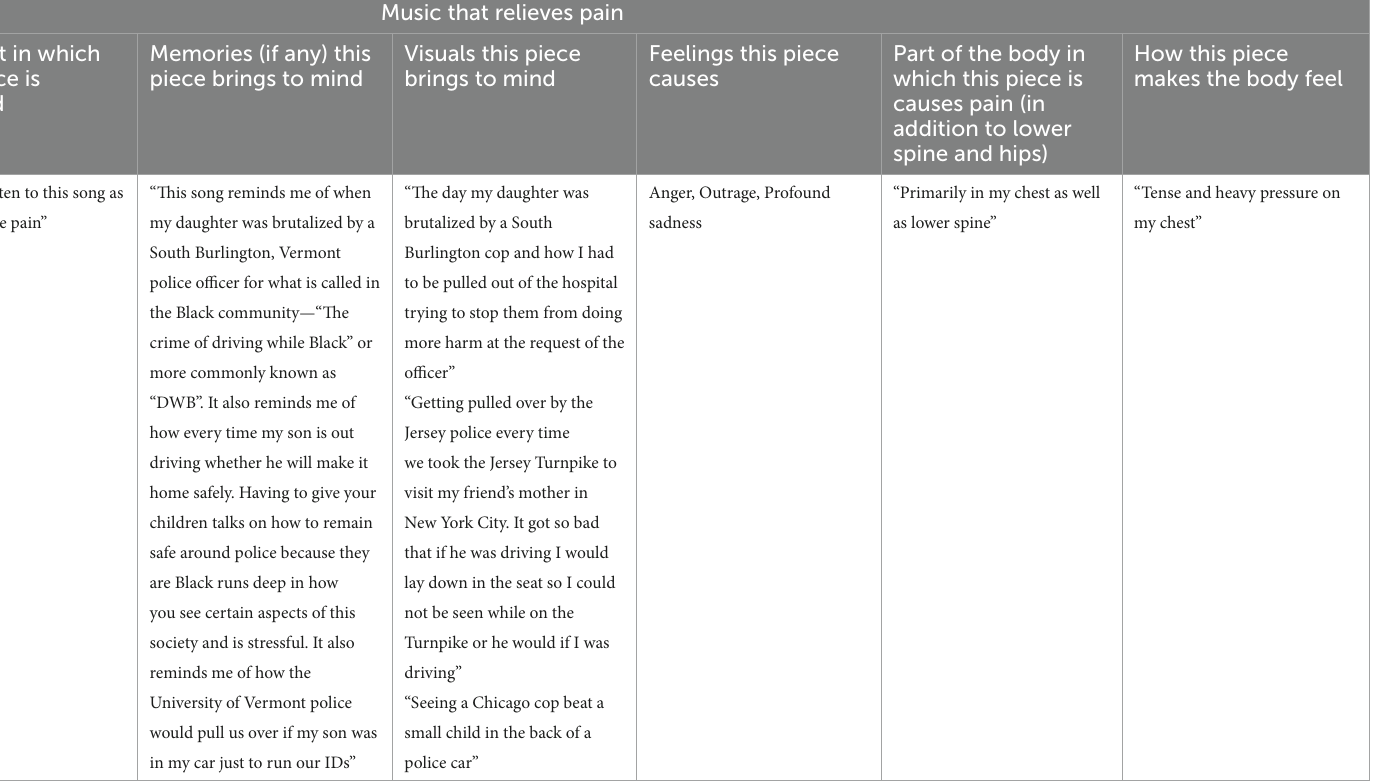
Music that relieves pain